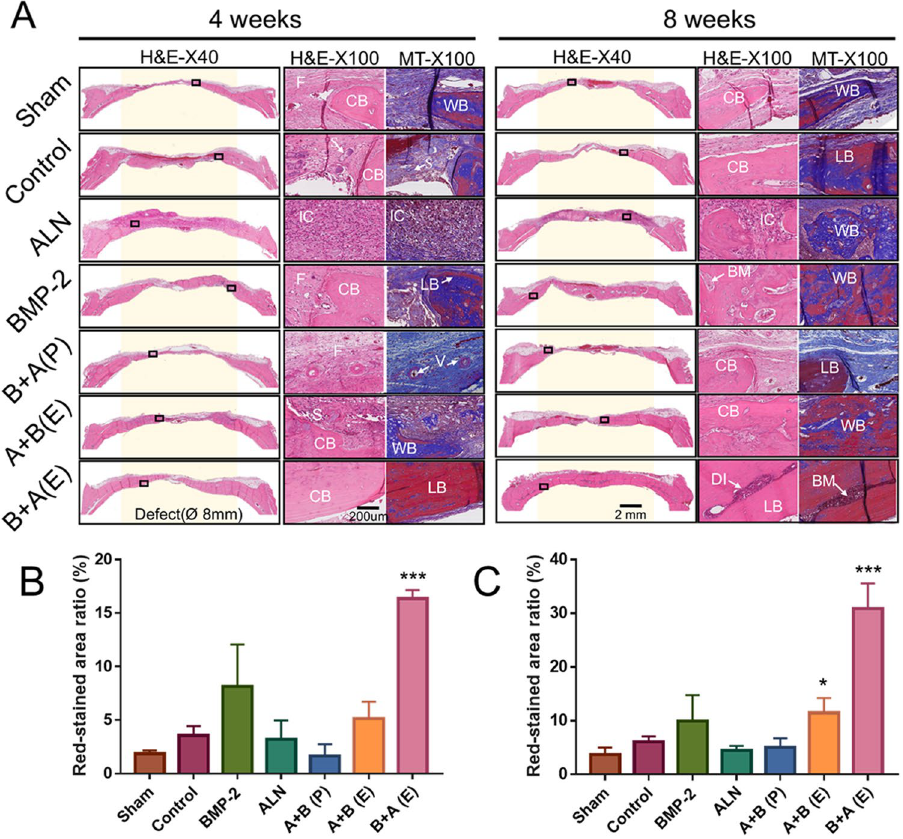
Figure 7. Histological evaluation of bone regeneration in rat calvarial defects at 4 and 8 weeks postoperatively: ( A ) Image for hematoxylin and eosin staining and Masson’s trichrome staining. Yellow background shows where defects were created. Semi-quantitative analysis of red-stained area ratio (%) of Masson’s trichrome staining in ( B ) 4 weeks and ( C ) 8 weeks using ImageJ software (V1.8.0_172, NIH, USA) (https ://image j.nih.gov/ij/). CB, cortical bone; LB, lamellar bone; WB, woven bone; F, fibrous tissue; IC, inflammation cell; S, scaffold; BM, bone marrow; DI, diploe; V: vessels. (×40 and ×100 magnification, scale bar = 200 μm. * p < 0.05; *** p < 0.001 versus control group; Two-way krANOVA